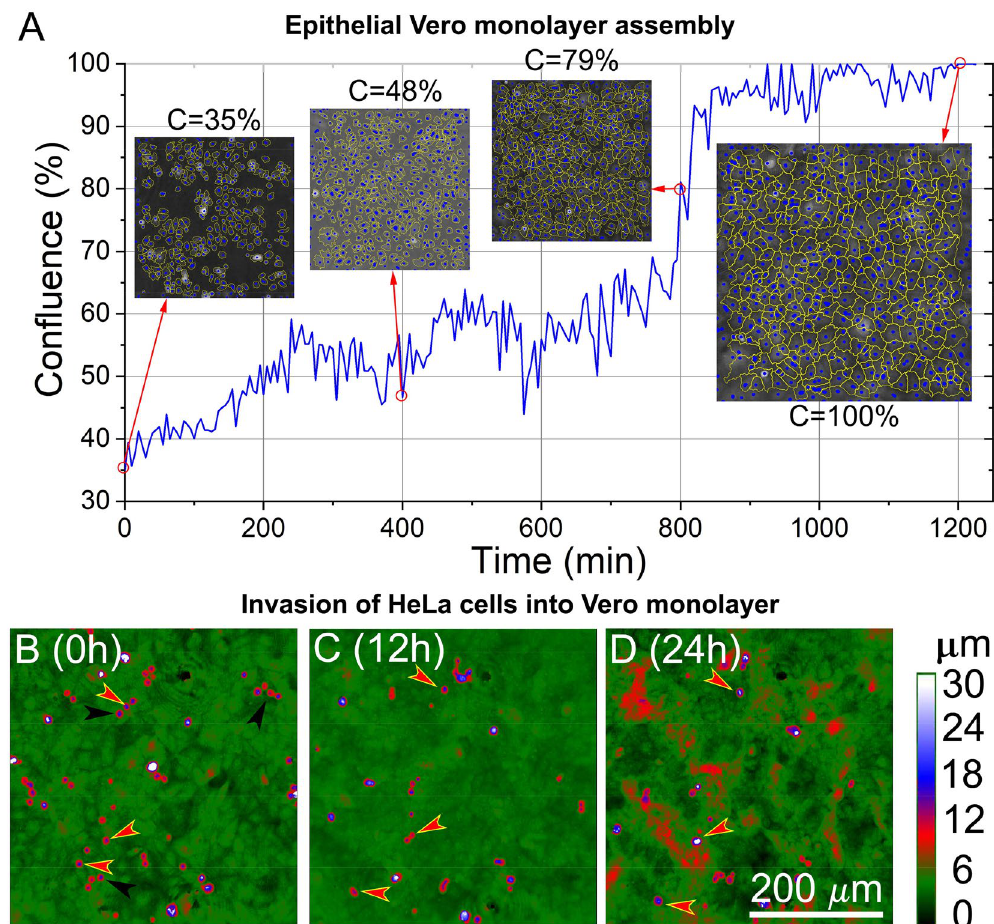
Figure 2. Maturation of the epithelial Vero monolayer and the invasion of HeLa cells. The eptihelial Vero monolayer was 100% confluent after 1200 min observed and quantified with HM ( A ). ( B – D ) Seeding, migration, and invasion of HeLa cells (0–12–24 h); It is visible that after 12 h of recording ( C ), some cells diminish from the view because of invasion and migration outside the frame. After 24 h of seeding HeLa, the smooth Vero monolayer ( D ) became rough and textured. Black arrows mark the three invasive, and red arrows with yellow outline mark the three non-invasive HeLa cells selected for detailed